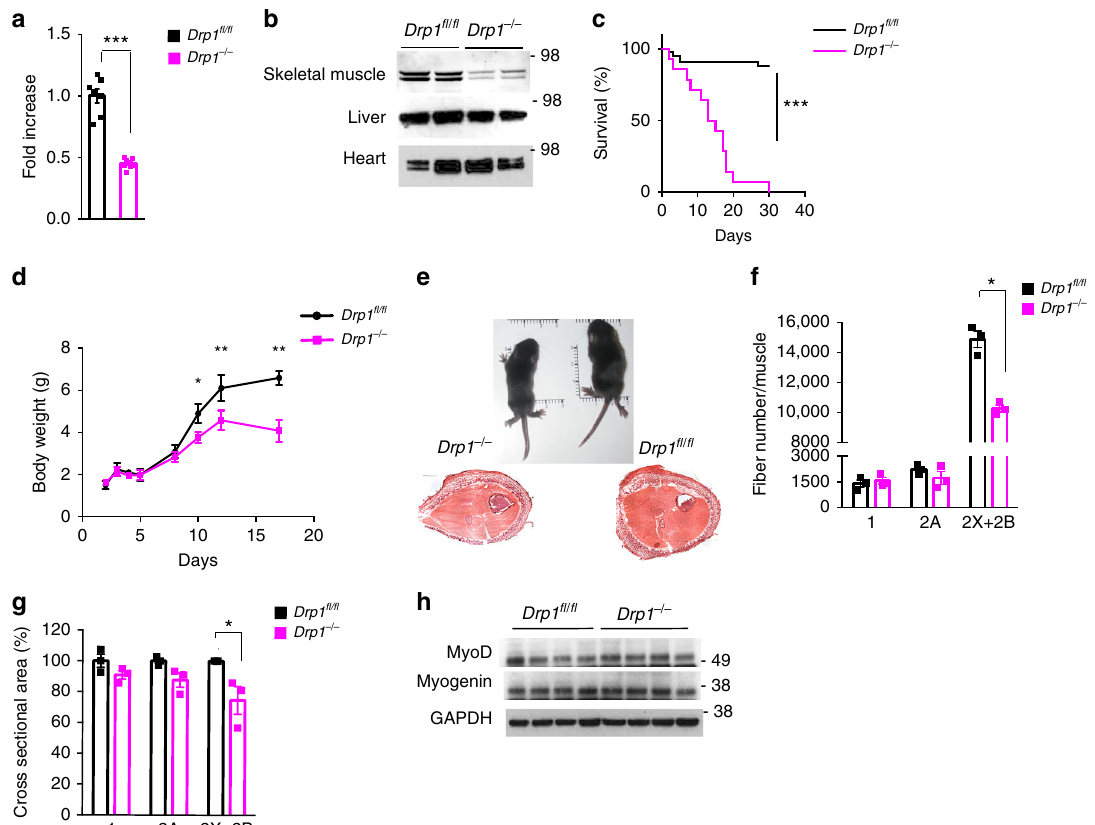
Fig. 1 DRP1 deletion impairs muscle growth and causes a lethal phenotype. Drp1 mRNA ( a ) and DRP1 protein levels ( b ) are downregulated only in